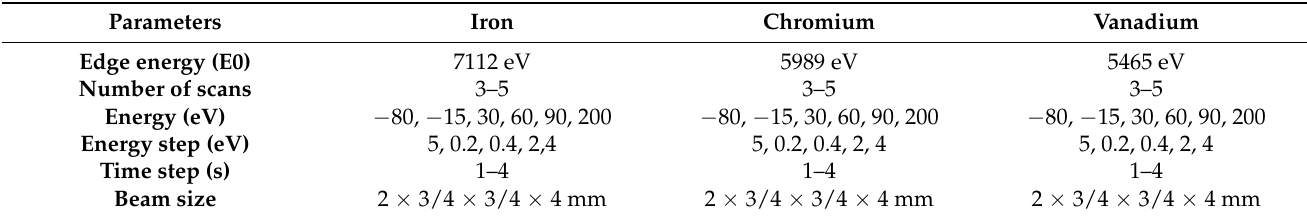
Table 1. XAS parameters for analysis of iron, chromium, and vanadium.